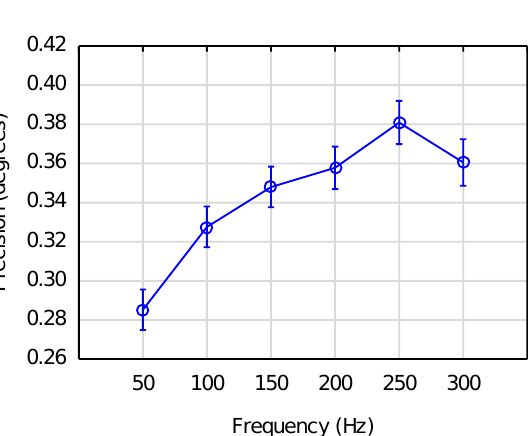
Figure 7: Average precision against sampling frequency. Vertical bars denote 95% confidence intervals.